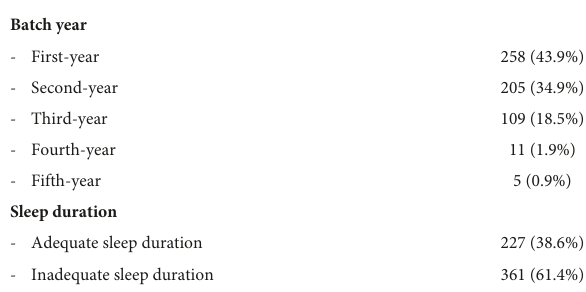
TABLE 1 Participants’